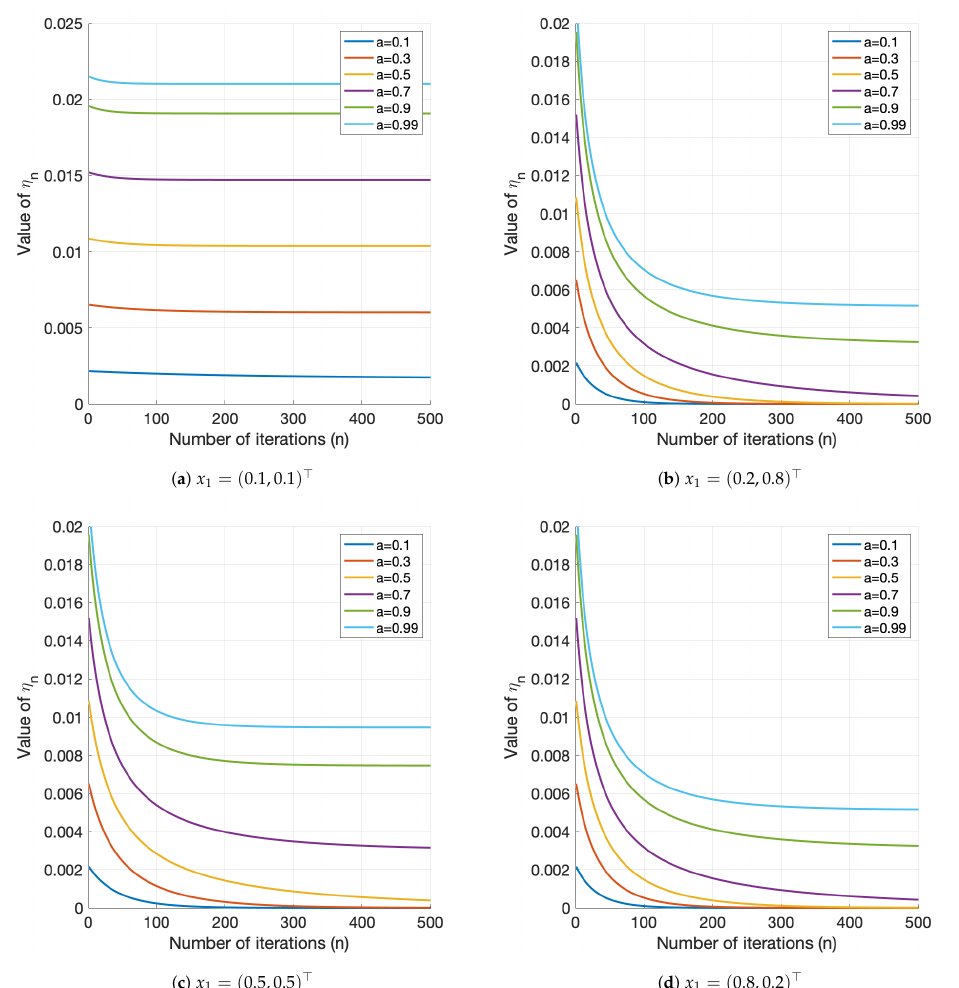
Figure 5. The behavior of the step size η n for different values of the initial point x 1 when performed by APGM with various values for a